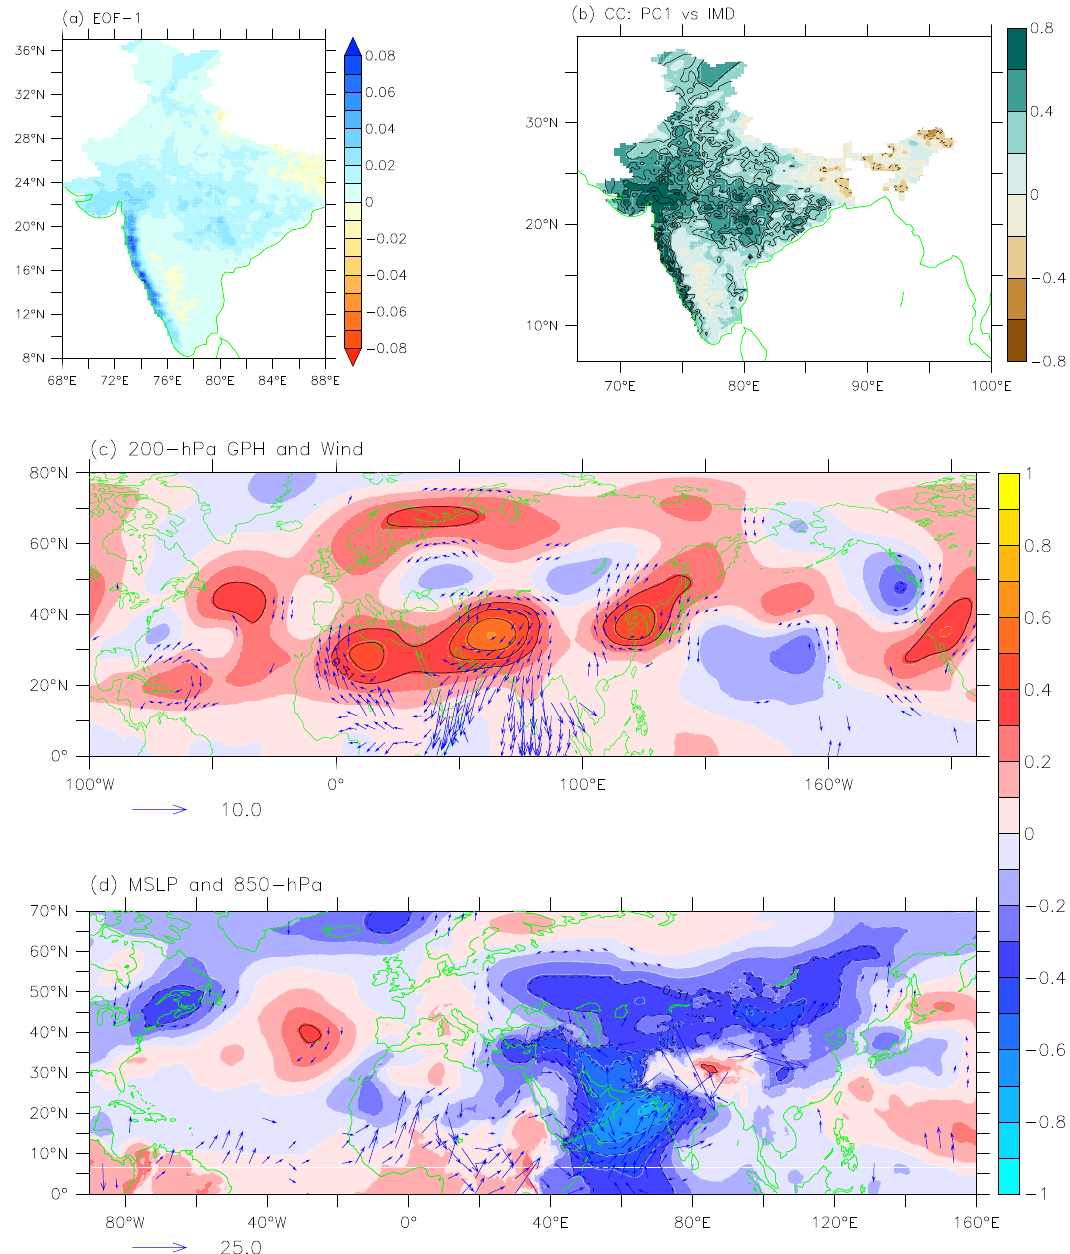
Fig. 2 IMD PC1 correlation. a The fi rst leading EOF of JJAS IMD rainfall anomalies (shaded), correlation of PC1 with b IMD gridded rainfall, c 200-hPa GPH (shaded) and regression of 200-hPa winds onto PC1 (blue vectors), d correlation of PC1 with MSLP (shaded) and regression of 850-hPa winds onto PC1 (blue vectors). Contours show the signi fi cance at 95% con fi dence